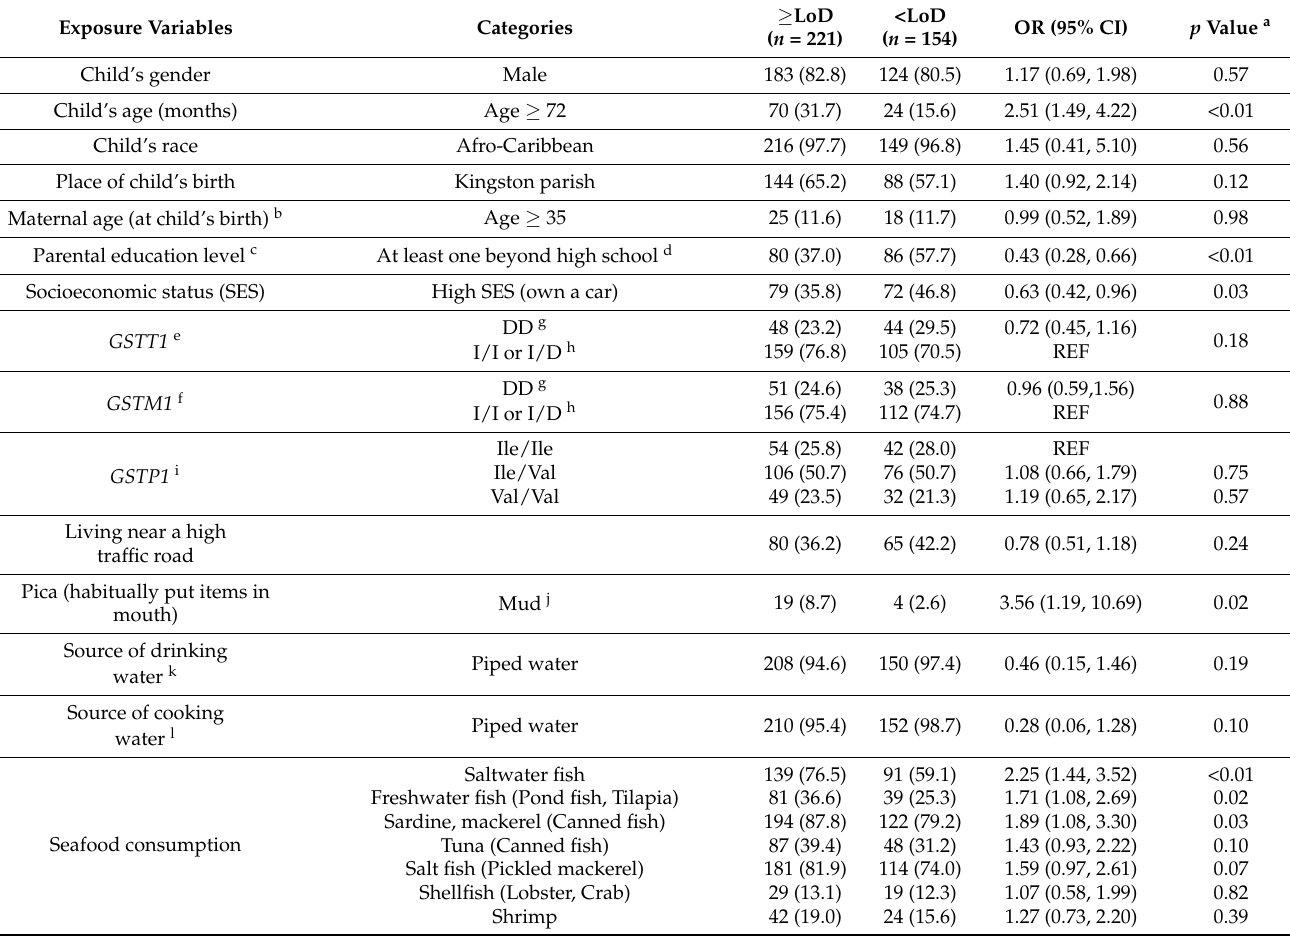
Table 2. Associations of environmental factors and children’s genotypes for GST genes with blood As concentrations based on univariable logistic regression models ( n =